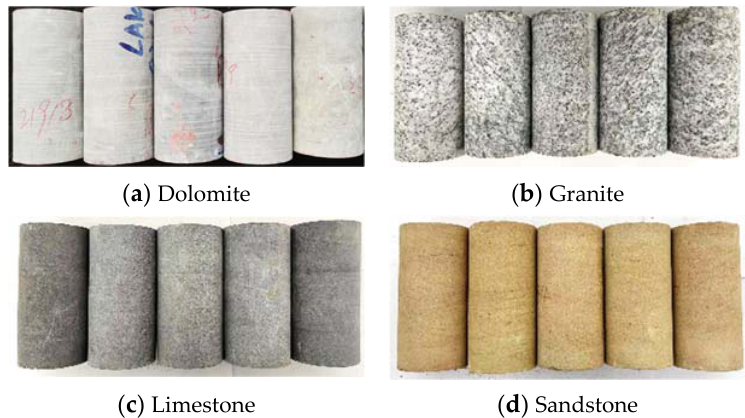
Figure 9. Different rock specimens.